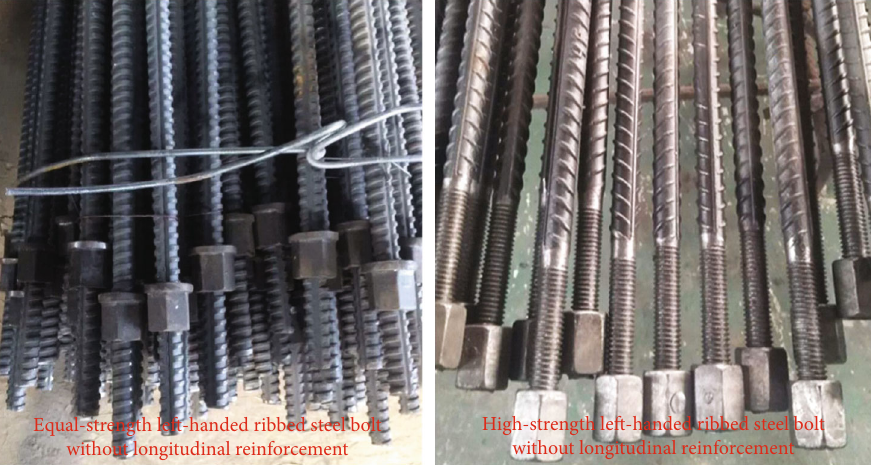
Figure 1: Bolt support materials. Table 1: Mechanical properties of bolts [22,